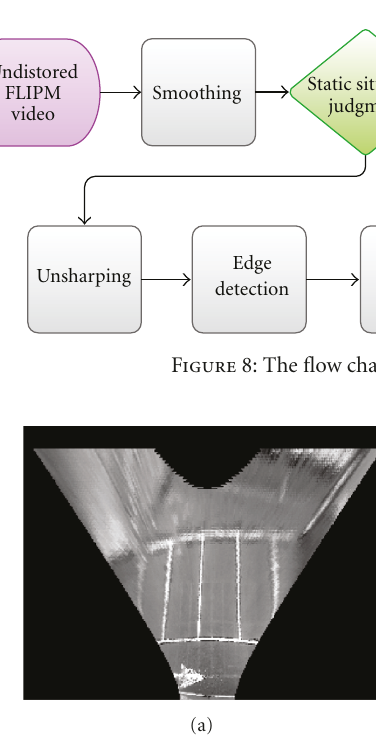
Figure 9: The results in the profile searching process, (a) the remapped image (b) the profile image.